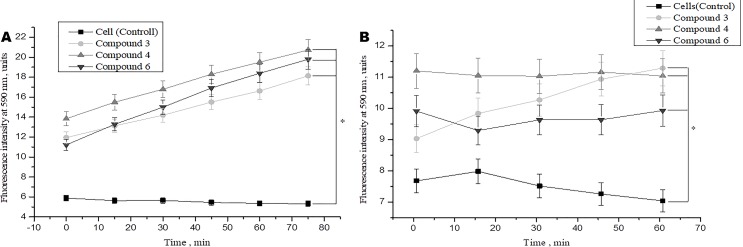
Effect of DNICs on the cell viability of human lung embryonic fibroblasts (cell line HLEF-104) (A) and rat cardiomyocytes (cell line H9c2) (B) for 60 min. DNICs (2 × 10-4 M) were added to cells, then cell viability was tested in fibroblasts and rat cardiomyocytes by AlamarBlue® Cell Viability Assay. *P ≤ 0.05 vs. control group, with ANOVAs followed by Tukey’s post hoc test. The values presented are the means ± SD of four independent experiments, n = 4.